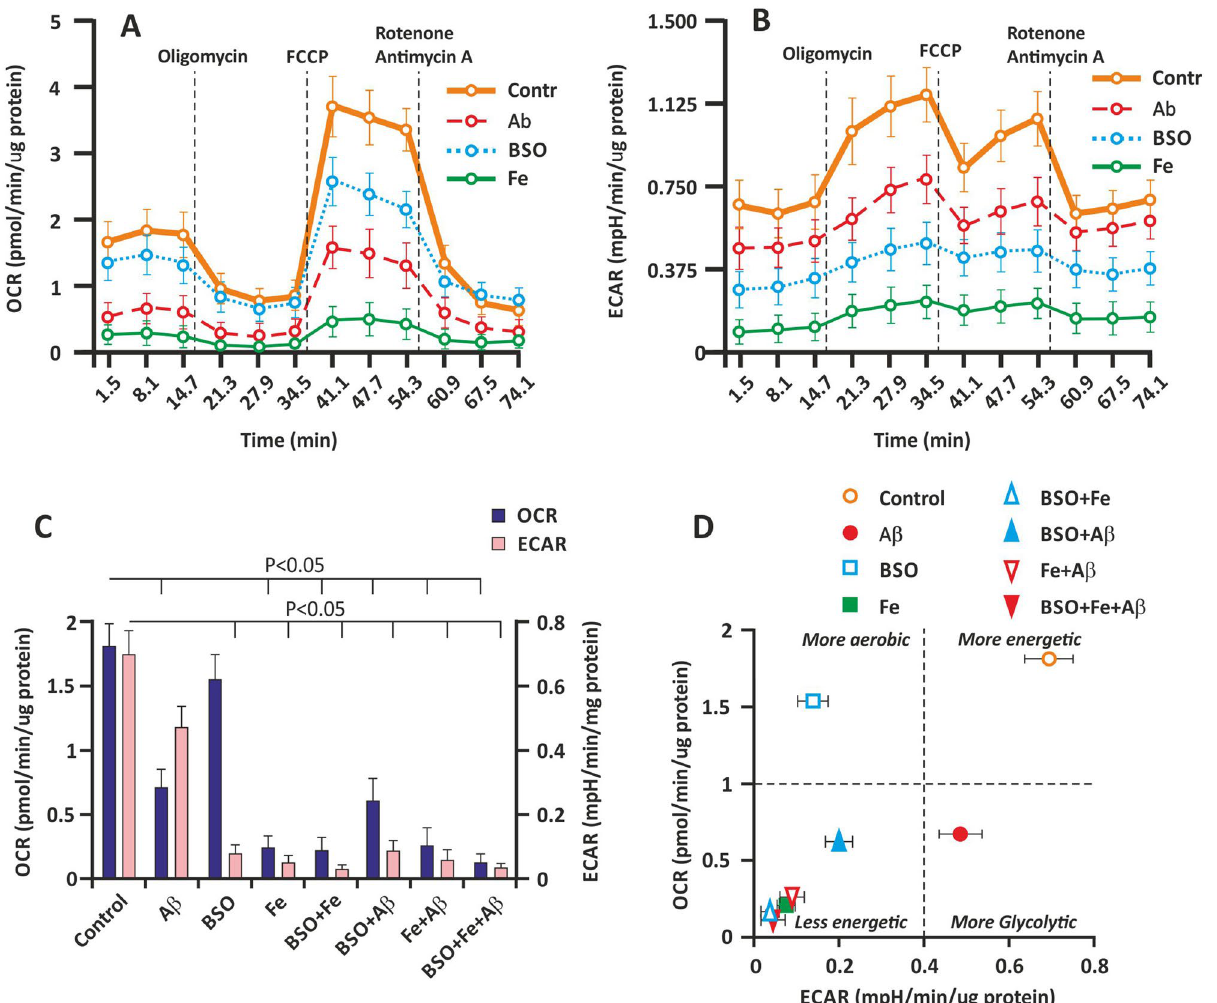
cultured hippocampal cells on the 3rd day of culture. ( B ) The ECAR of cultured hippocampal cells on the 3rd day of culture. ( C ) Basal OCR and ECAR. ( D ) Metabolic profiles of hippocampal cells. Analyses were conducted using Wave software and XF Report Generators (Agilent